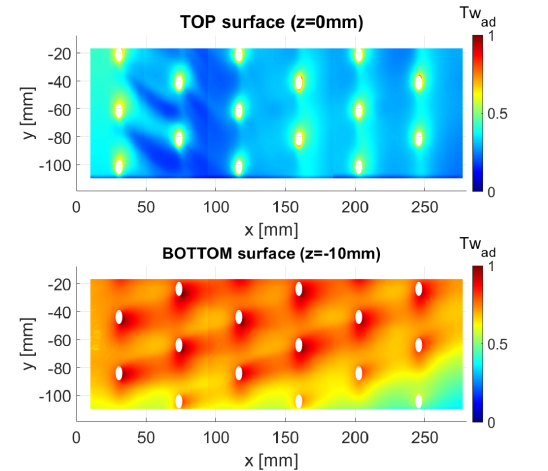
Figure 23. Wall temperature of the multiperforated plate without electrical